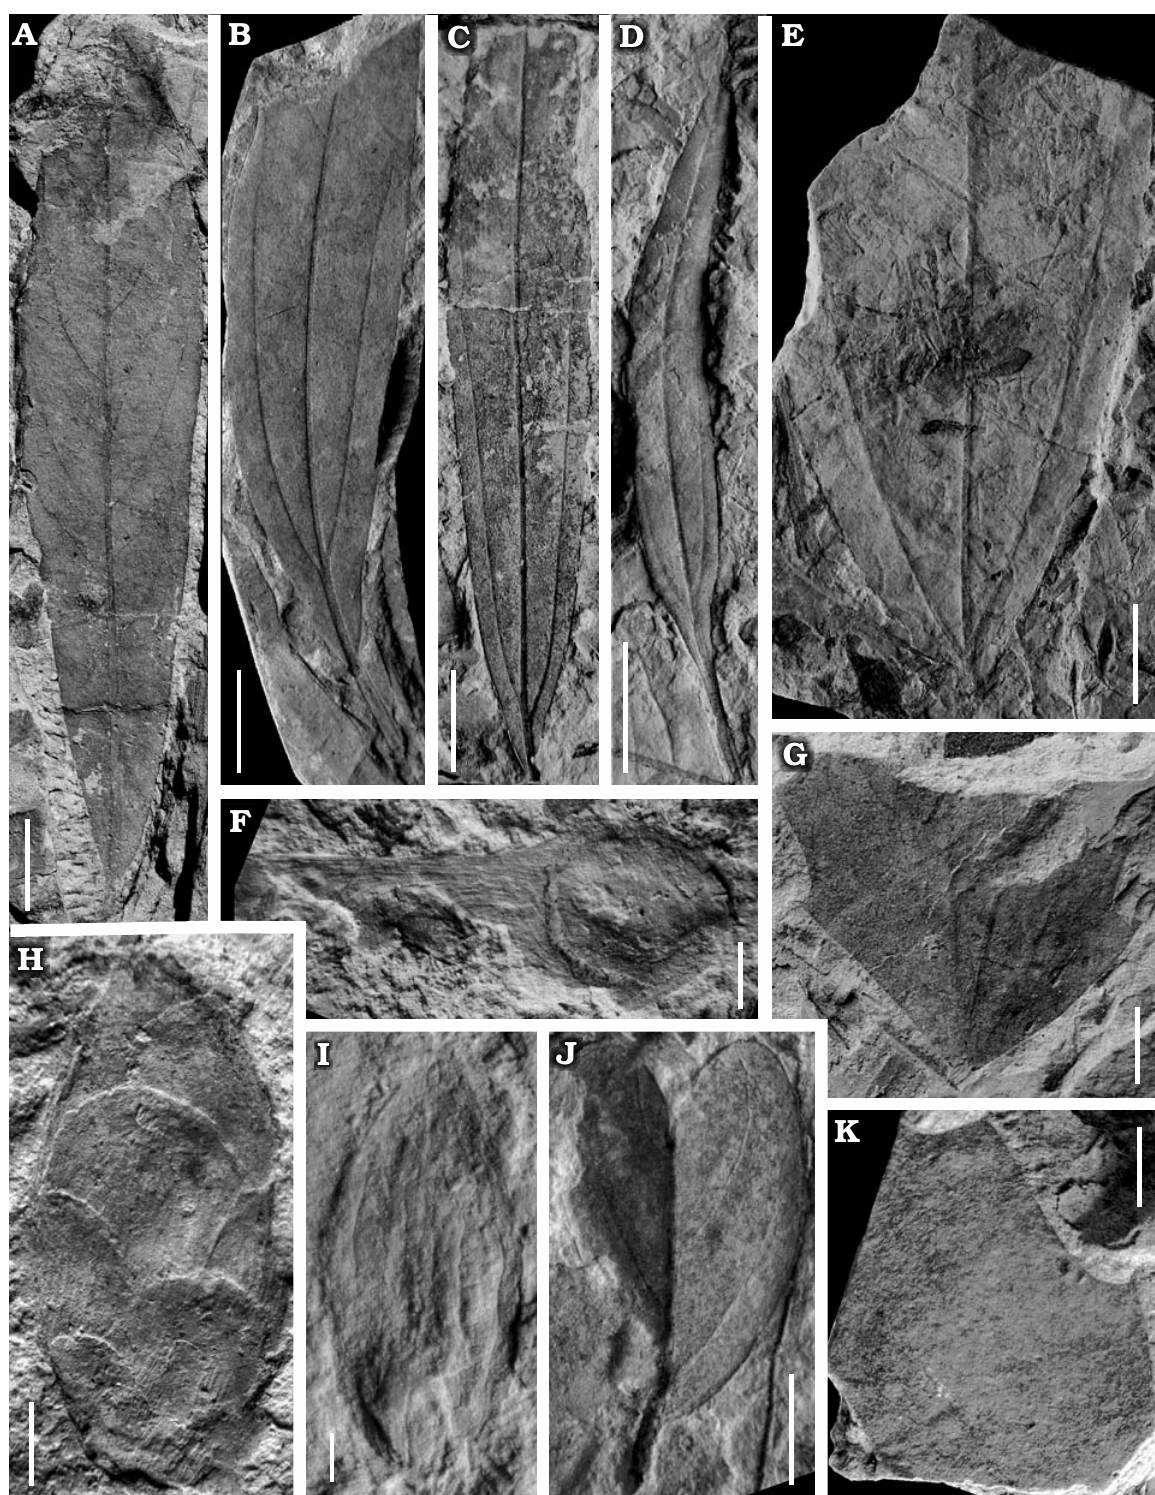
Fig. 4. Angiosperms impressions from Ł ysa Góra near R ę biszów, Poland, late Oligocene. A . cf. Laurophyllum acutimontanum Mai, 1963, leaf, KRAM-P 128/436. B – D . Daphno gene cinnamomifolia (Brongniart, 1822) Unger, 1850 forma lanceolata sensu Kva č ek and Walther (1995), leaves. B . KRAM-P 128/131. C . KRAM-P 128/397. D . KRAM-P 128/298. E . Daphnogene cinnamomifoli a (Brongniart, 1822) Unger, 1850 forma cinnamomifolia sensu Kva č ek and Walther (1995), KRAM-P 128/256, leaf. F . Acer cf. polymorphoides Mai, 1987, KRAM-P 128/415, fruit. G . Mahonia sp., KRAM-P 128/35, leaf. H . Tsuga cf. moenana Kirchheimer, 1935, KRAM-P 128/75, cone. I . Ostrya atlantidis Unger, 1850, KRAM-P 128/318, fruit. J . cf. Leguminosites sp. or cf. Rhodomyrtophyllum sp., KRAM-P 128/88, leaf. K . Mahonia sp., KRAM-P 128/291, leaf. Scale bars: A–E, 10 mm; H, G, 5 mm; K, 3 mm; F, H, J, 2.5 mm; I, 1